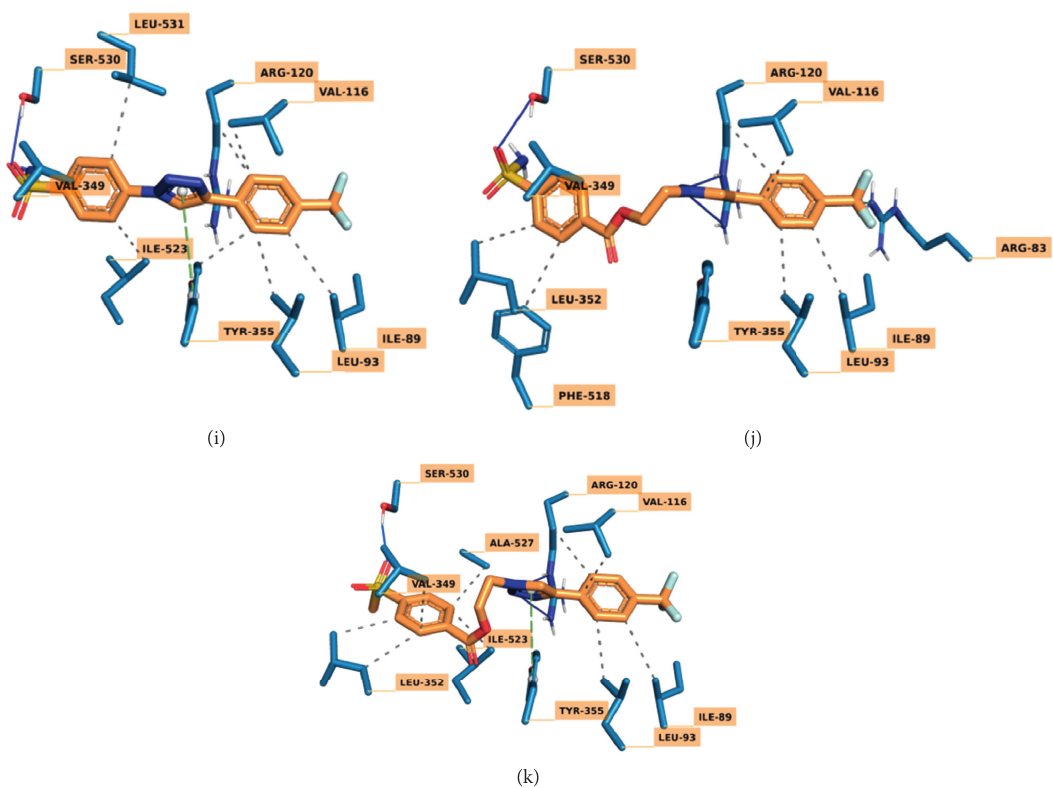
Figure 2: Predicted binding orientations of (a) 4a , (b) 4b , (c) 4c , (d) 4d , (e) 4e , (f) 4f , (g) 4g , (h) 8a , (i) 8b , (j) 15a , and (k) 15b visualized in COX-1 active site (PDB code 3KK6 [31]); ligands are shown in orange and amino acids are shown in blue. Only the interacting residues and their interaction patterns are